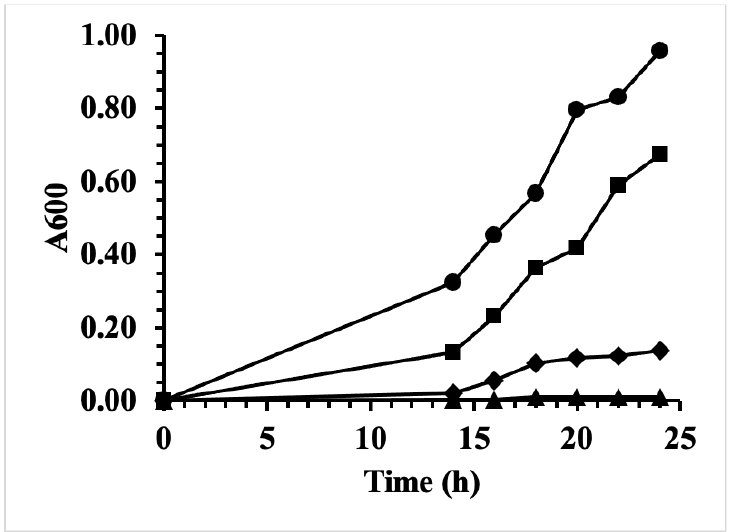
Figure 1. Antibacterial effect of extract from rhubarb stalks. Growth inhibition of the A. actinomycetemcomitans strain Y4 in 5 mL medium by increasing amounts of aqueous extract from rhubarb stalks: 0 μL (circles), 80 μL (squares), 150 μL (diamonds), and 200 μL (triangles).